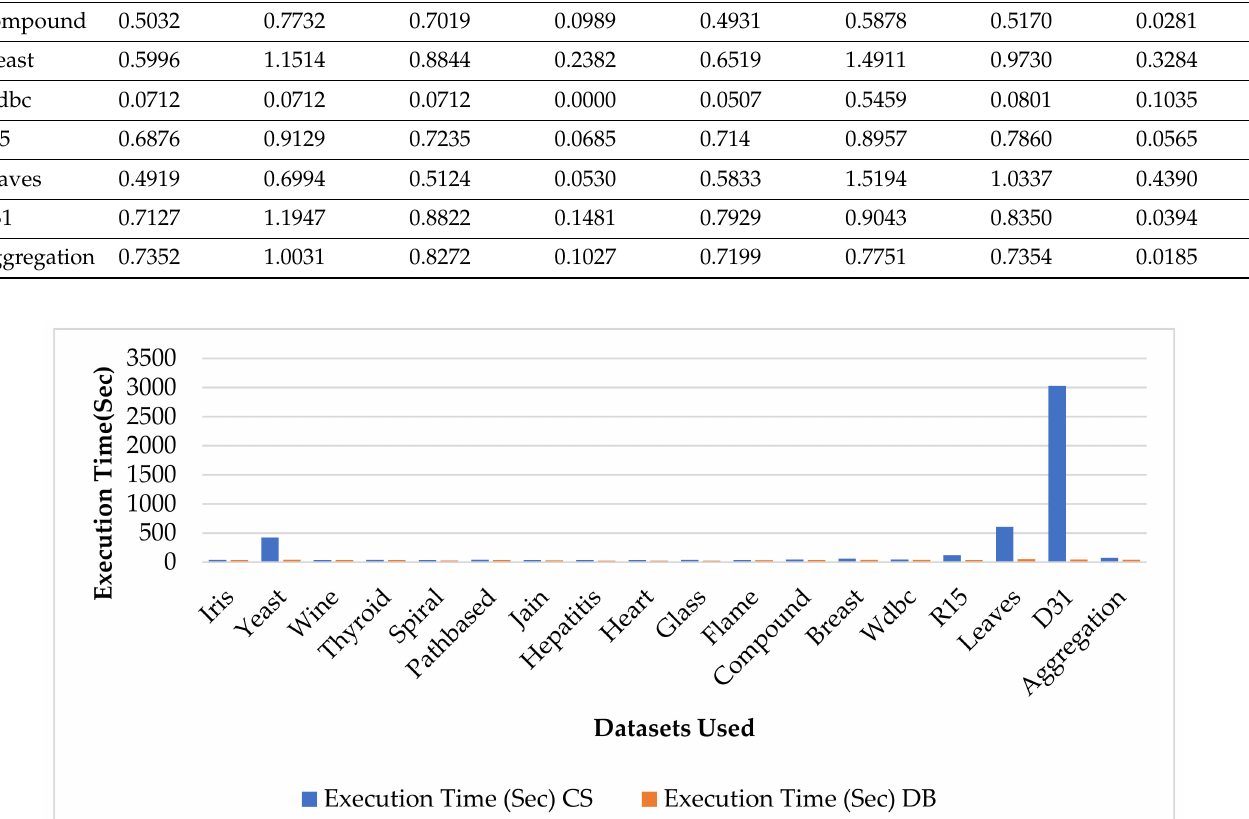
Figure 3. Average execution time taken by HFAPSO on CS and DB indices for all the datasets used over 20 independent